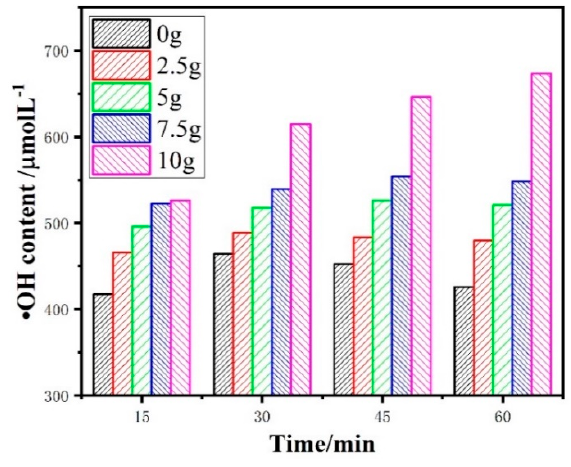
• OH content under di ff erent Sb–SnO Figure 2. The •OH content under different Sb–SnO 2 magnetic particle dosage. Figure 2. The